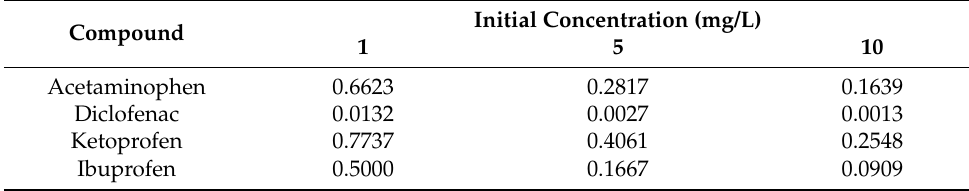
Table 8. R L value of the metals in the Langmuir isotherm.